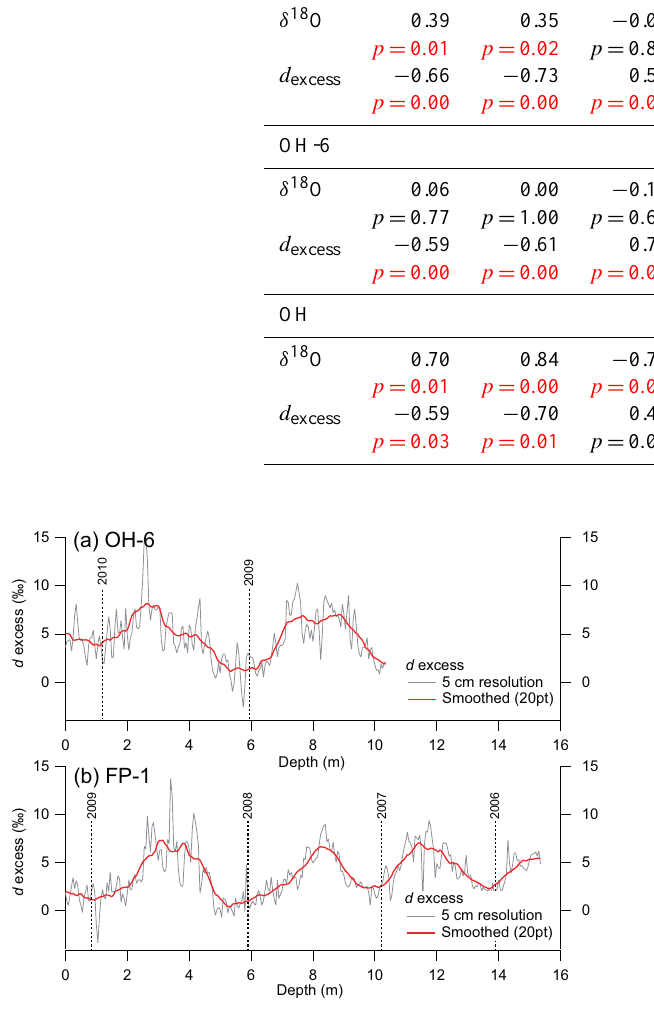
Fig. 12. Firn cores d excess high resolution (5cm samples, red line) and smoothed (20 points, red line) signal of: (a) OH-6, retrieved in January 2010 at the Laclavere Plateau (Antarctic Peninsula); and (b) FP-1, retrieved in January 2009 at the main dome of King George Island (South Shetland Islands). A clear seasonality is visi- ble for both cores, however a decrease of the amplitude is observed for the core FP-1 in depth, showing some post-depositional effects. The deposition year of firn for both cores are shown (black dashed lines – approximately the first day of the